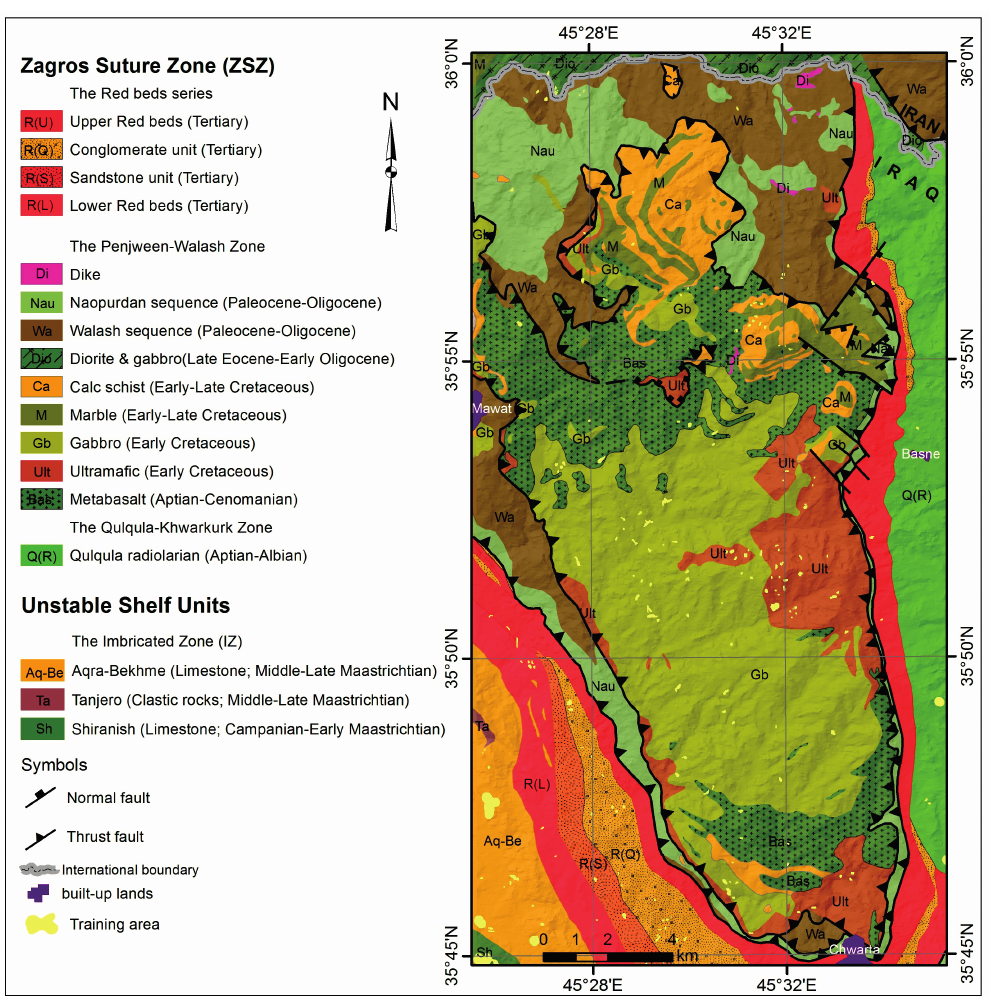
Figure 2. Geological map overlaying the DEM from ASTER of the Mawat area that indicated in Figure 1 (compiled after